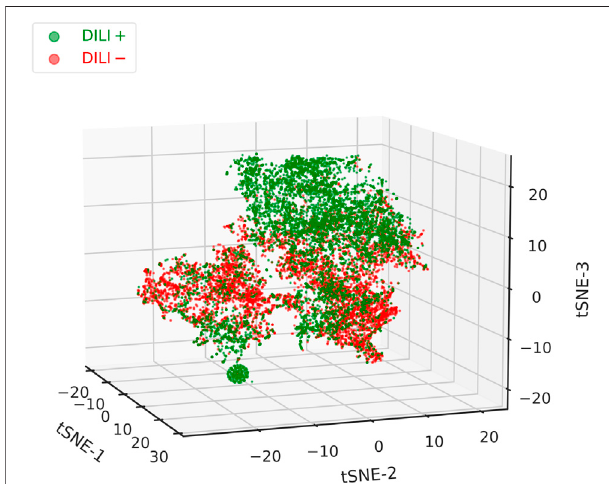
FIGURE 3 | 3D t-SNE plot of all the non-zero external feature vectors (which combine both chemical and disease embeddings). A good degree of separationcanbeobservedbetweentheDILIpositiveandnegativetexts,with theformerclusteringcleanlyonthetop-rightcorneroftheplot.Asecond denseclusterisformedatthebottom-leftcorner.Betweenthem,inthemiddle part of the plot, reside both positive and negative texts that did not form distinct clusters. While feature vectors can improve classi fi cation performance,theytendtobesparseandshould,therefore,notbeusedasthe single input to the classi fi er.